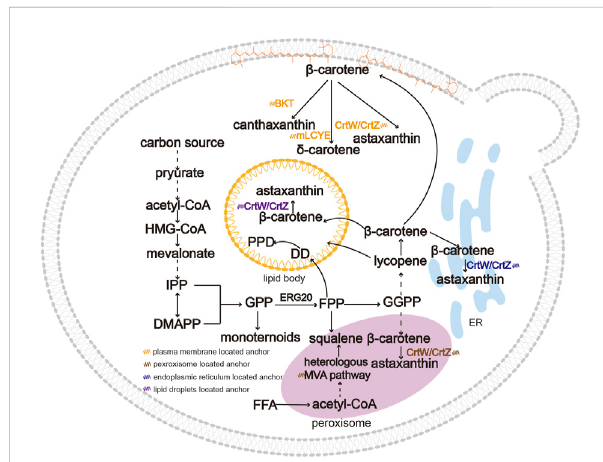
FIGURE 3 An overview of subcellular compartmentalization for the biosynthesis of triterpenoids and tetraterpenoids. Due to their hydrophobicity, triterpenoids and tetraterpenoids are generally sequestered in speci fi c organelles such as LDs, peroxisomes, ER and plasma membrane. Product distribution in strains reduces cytotoxicity and causes spatial separation between substates and products. Moreover, targeting the pathway to more than one compartment can increase the product titer compared to single subcellular compartmentalization. Abbreviations: BKT, β -carotene ketolase; mLCYE, lycopene ε